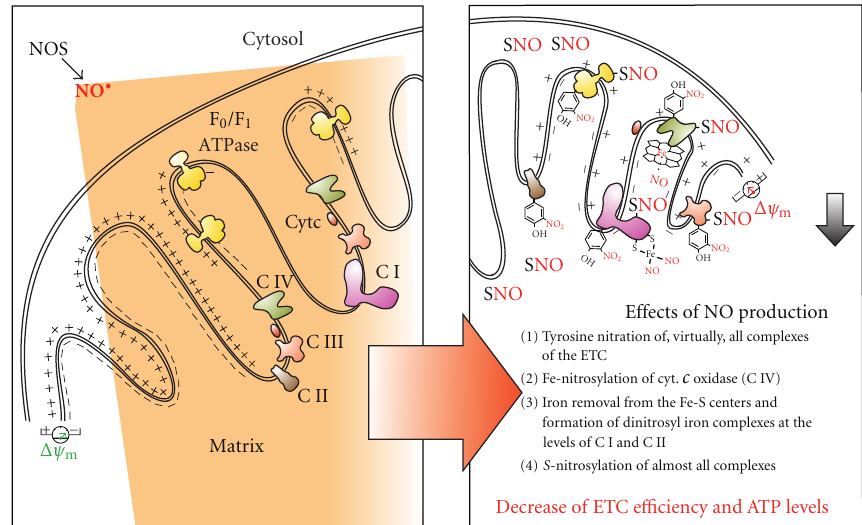
Figure 3: E ff ects of NO and nitrosative stress on mitochondrial electron transfer chain. NO, namely, the fraction produced in the cytosol by NOS, can cross cell membranes (e.g., the mitochondrial outer and inner membranes) and reversibly or irreversibly modifies mitochondrial complexes of the electron transfer chain (ETC). Specifically, nitration of all complexes, nitrosylation of Fe-heme-containing cytochrome c oxidase (C IV), generation of dinitrosyl iron complexes of Fe-S centers (e.g., those present in the Complex I), and S -nitrosylation of Complex I, III, IV, F 0 /F 1 ATPase, as well as other unspecified mitochondrial proteins are shown. These modifications negatively a ff ect ETC e ffi ciency, and ATP production and decrease mitochondrial transmembrane potential ( ΔΨ m ), which represents e crucial event upstream of several mitochondrial functions, such as mitochondrial dynamics, mitophagy, and